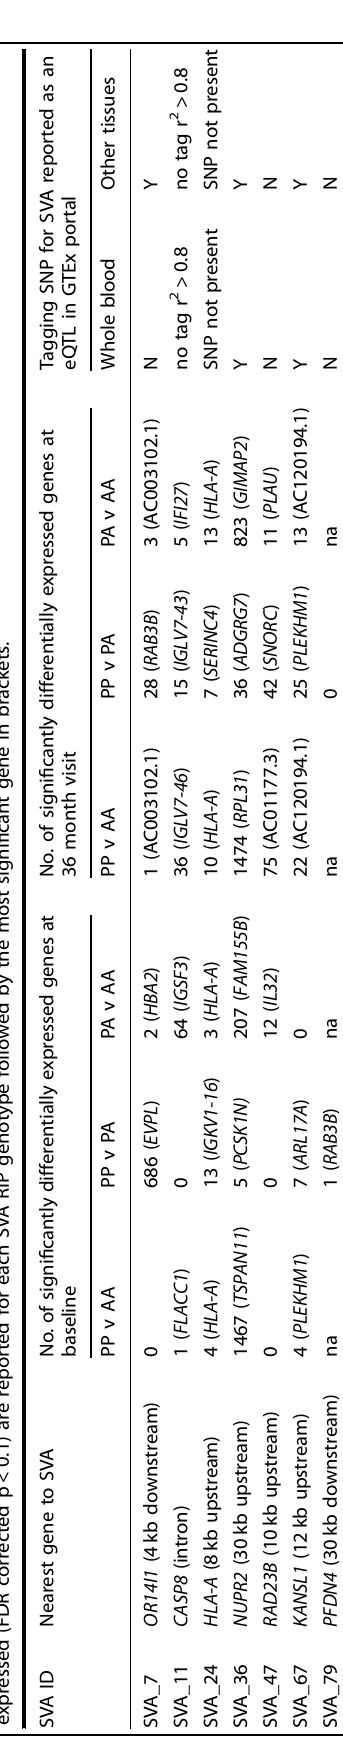
the recruitment of transcription factors, the interaction of SVAs with distant promoters through 3D chromatin structure and intronic insertions affecting mRNA splicing. Regulatory domains can function in a tissue-speci fi c manner and therefore we utilised the GTEx database 23 to evaluate the potential for the SVAs to act in other tissues using their proxy SNPs. Tagging SNPs for fi ve out of the seven SVAs were located in the GTEx database and three of T a